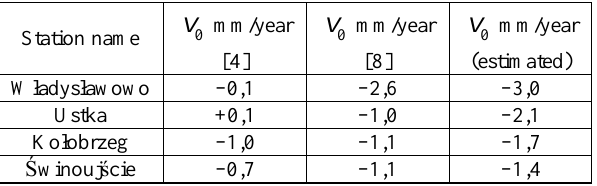
Table 2. Vertical movements at the tide gauge stations in Poland and their standard deviations